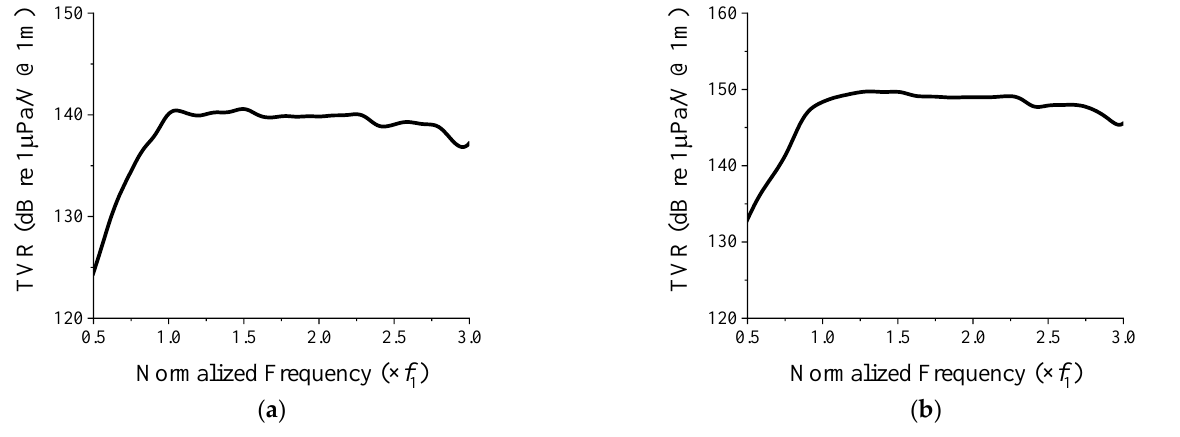
Figure 17. TVR spectra of the two-layered cymbal arrays with a frame: (a) 3 × 3 array; (b) 5 × 5 array. Figure 18 presents the comparison of the results shown in Figures 17a and 5b for the two-layered 3 × 3 array with and without a frame, respectively, for a CTC spacing of 0.2 𝜆 . From the figure, we can conclude that the effect of the frame on the TVR spectrum of the array is negligible.